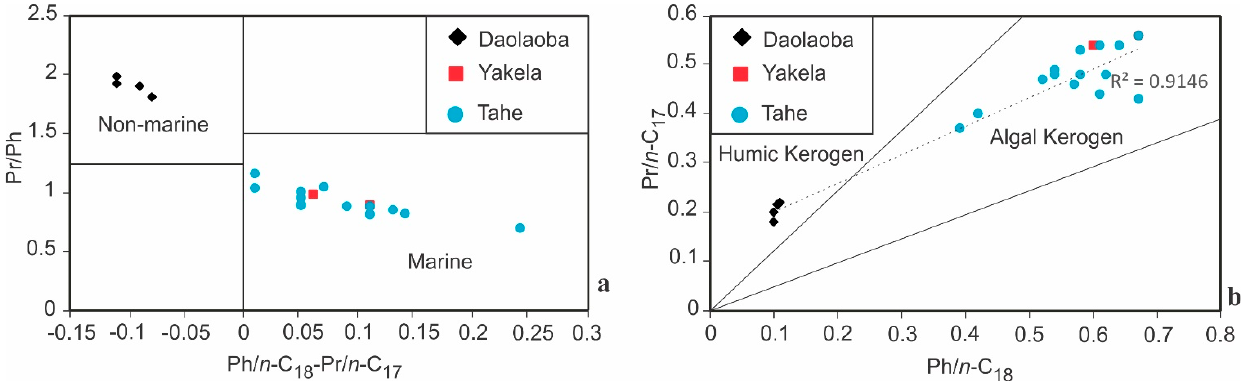
Figure 3. ( a ) Pristane/Phytane ratios vs. Phytane/ n -C 18 –Pristane/ n -C 17 values plot of the oils from Tarim Basin (Modified after Song et al., 2015 [27]). ( b ) Pr/ n -C 17 versus Ph/ n -C 18 of 20 selected oils from the Tarim Basin.